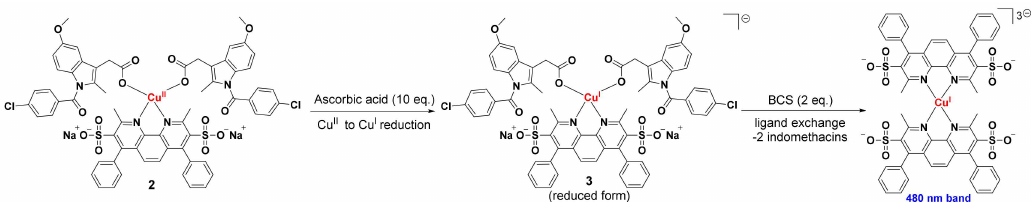
Scheme 1. Proposed reaction scheme for the reduction of 2 by ascorbic acid (10 eq.) and subsequent reaction with bathocuproinedisulfonic acid disodium in PBS:DMSO (200:1) at 37 ◦